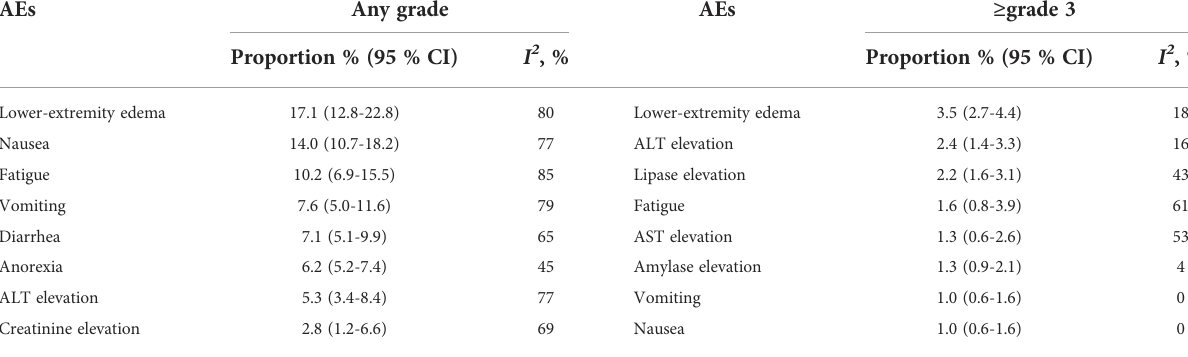
TABLE 4 Pooled results of common AEs of any grade and ≥ grade